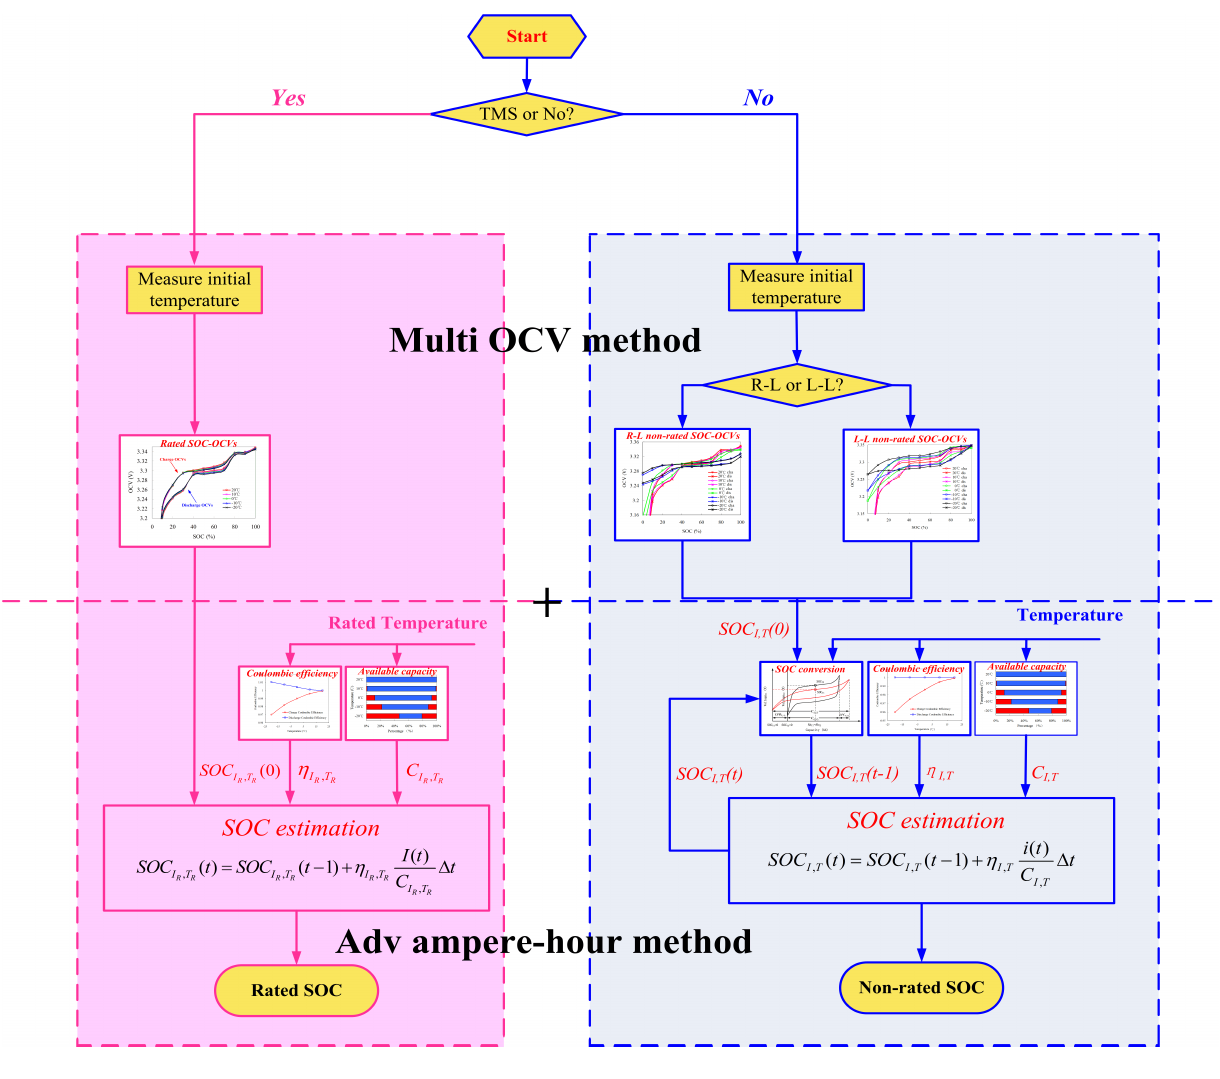
Figure 17. Chart of battery SOC estimation at different ambient temperatures.